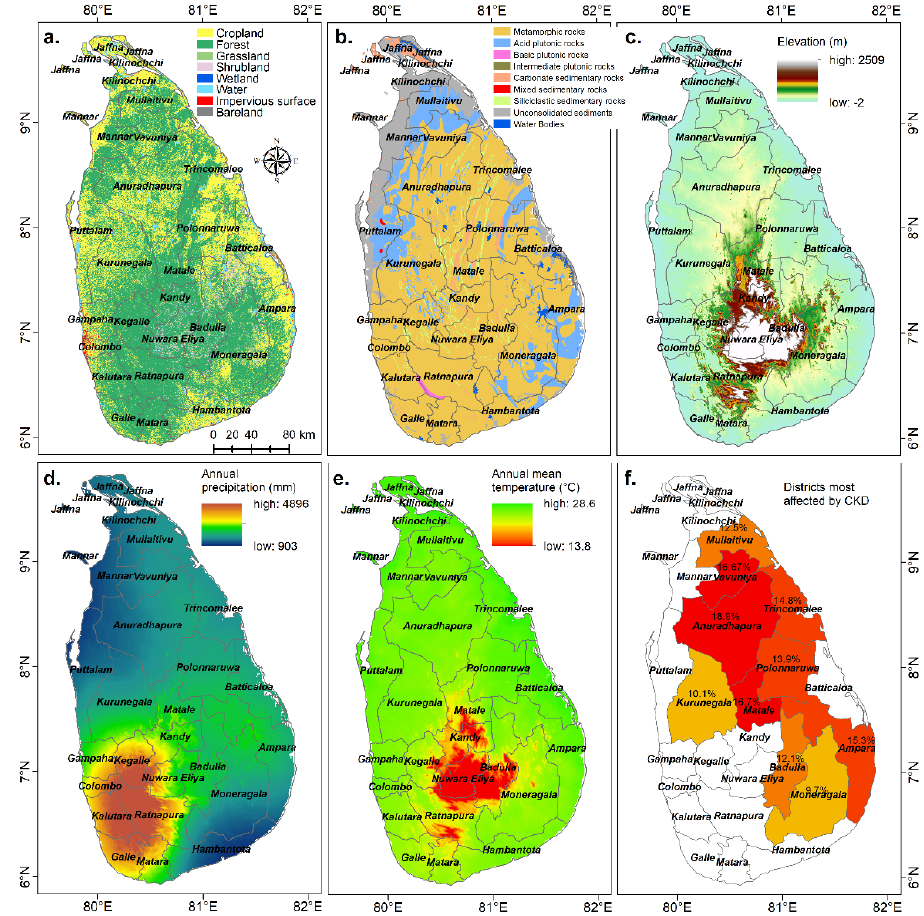
Figure 1. Maps showing ( a ) land use, ( b ) lithology, ( c ) elevation, ( d ) annual precipitation, ( e ) annual mean temperature, and ( f ) CKD prevalence rates across the most affected districts in Sri Lanka [10].